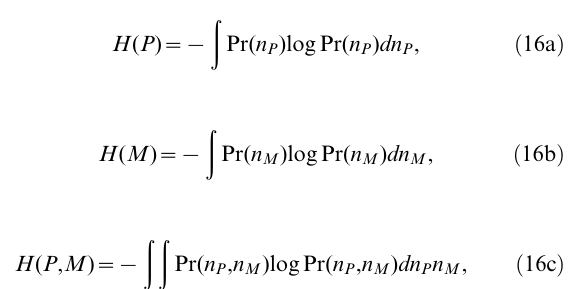
doi:10.1371/journal.pone.0022487.g003